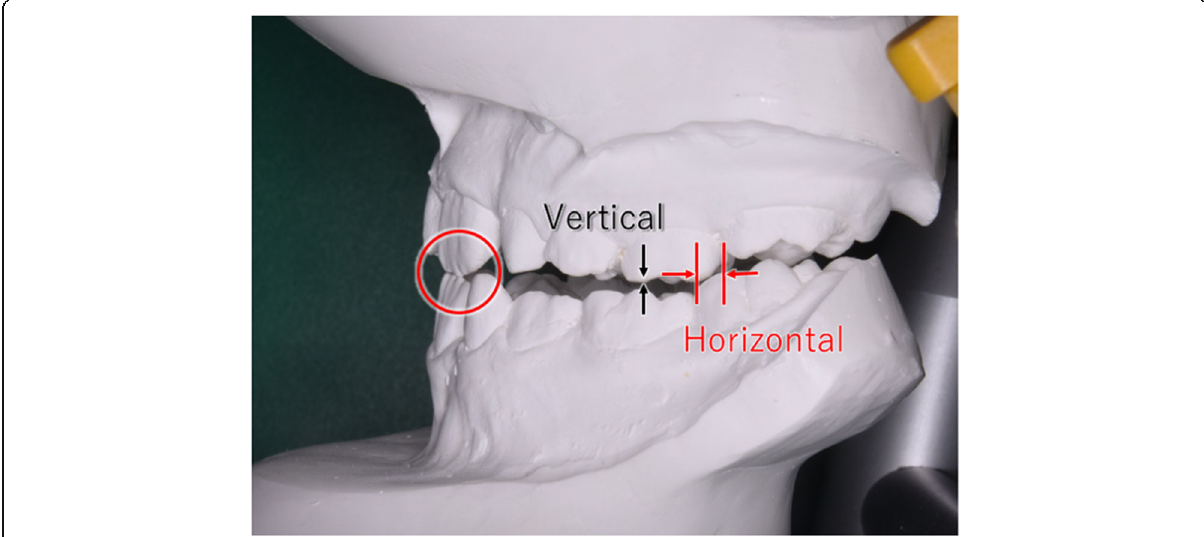
Fig. 1 Horizontal and vertical distances on the mounted dental casts. The horizontal distance between the mesial contact point of the maxillary first molar and the mesial contact point of the mandibular first molar was measured bilaterally. The vertical distance between the mesiobuccal cusp of the maxillary second primary molar and the mesiobuccal cusp of the mandibular second primary molar was measured bilaterally